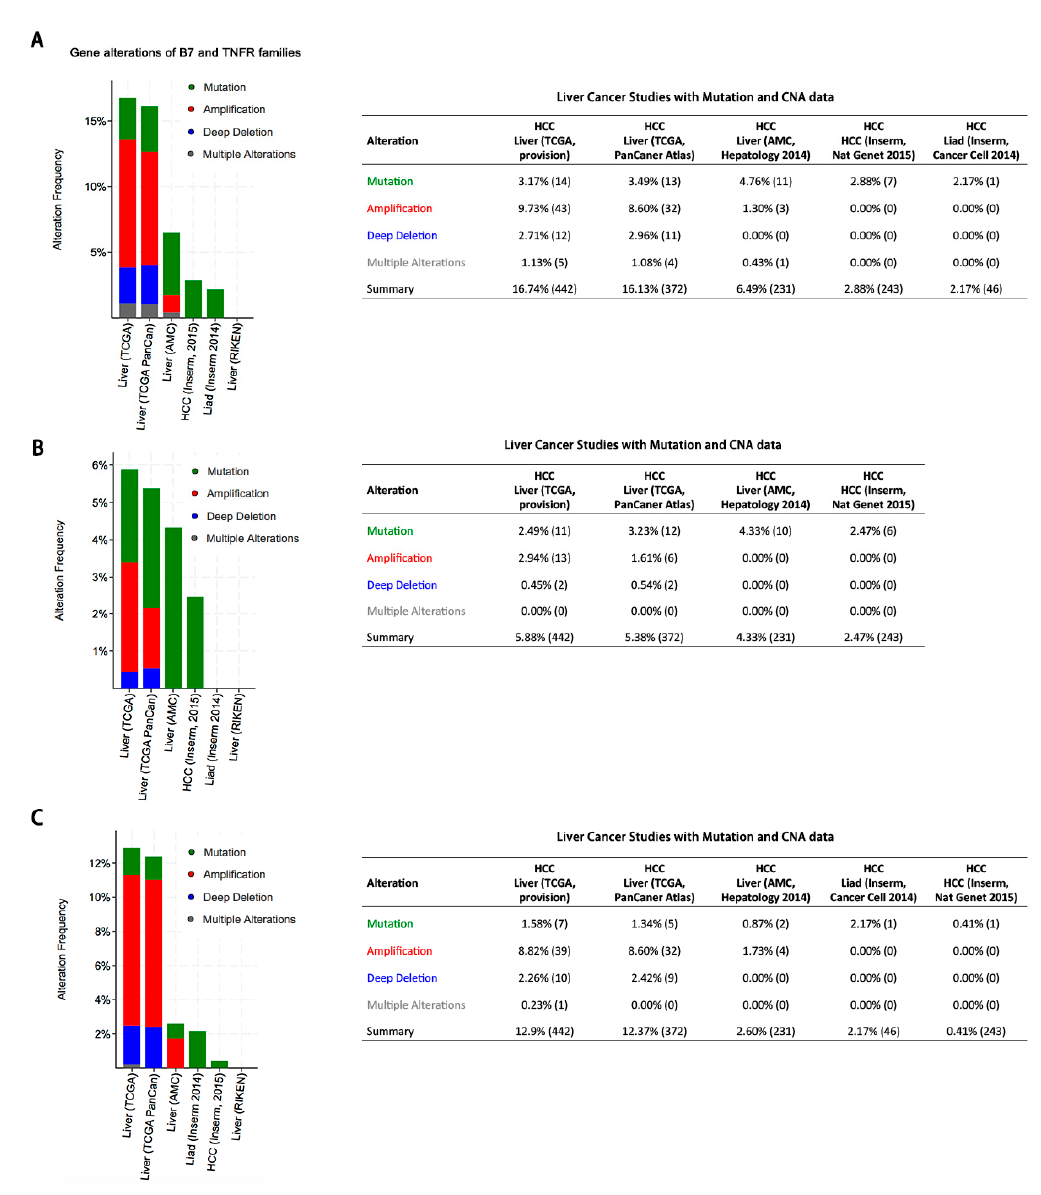
Figure 1. Gene alteration frequencies in the B7 and TNFR families across six HCC studies. ( A ) Gene alterations of B7 and TNFR families. ( B ) Gene alterations of B7 family. ( C ) Gene alterations of TNFR family.